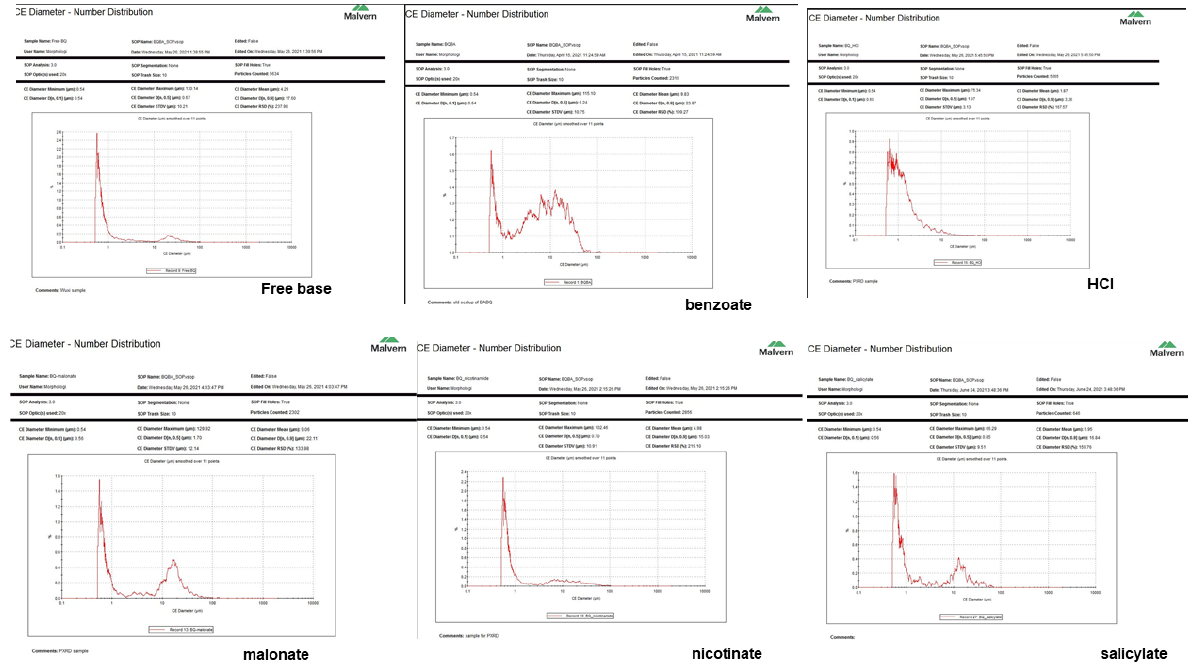
Figure A1. Circle equivalent (CE) diameter number distributions for bedaquiline free base and the new salts.